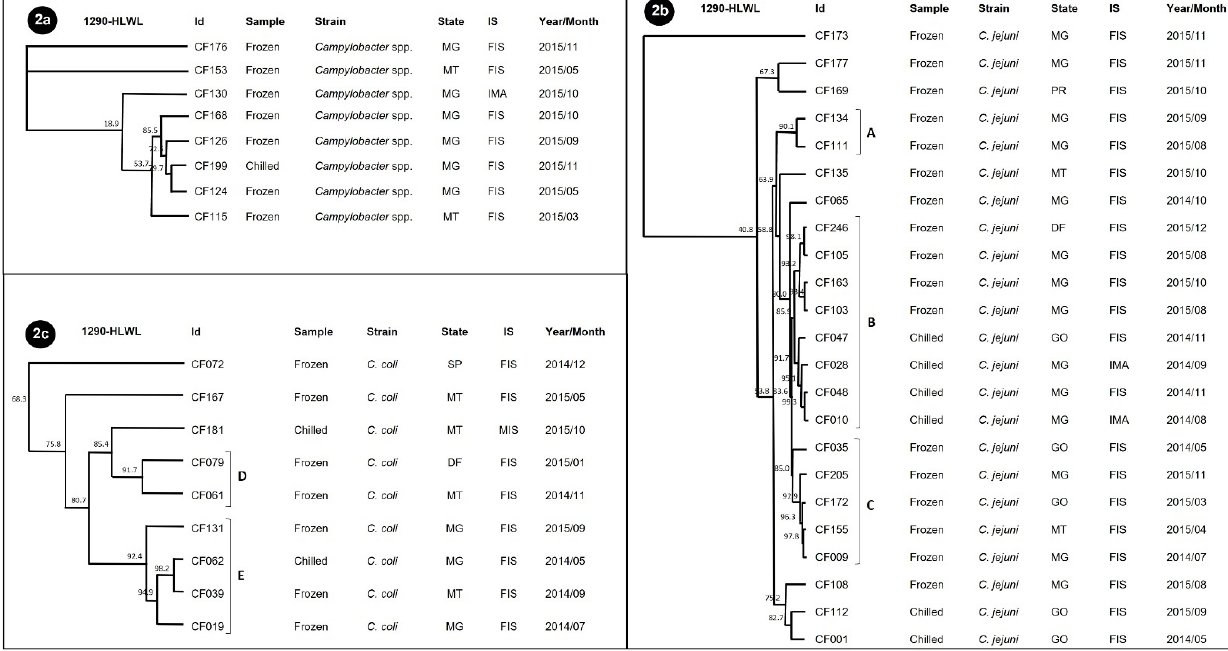
Figure 2. Dendrogram of the 40 Campylobacter spp. isolates from chilled and frozen chicken carcasses, from data generated by the RAPD-PCR technique with primers 1290 and HLWL, using the average from experiments and the UPGMA method with 85% optimization by the GelCompar program. ( 2a ) Results found for Campylobacter spp. ( 2b ) Results found for C. jejuni : ( A ) cluster with 90.1% homology; ( B ) cluster with 85.9% homology; ( C ) cluster with 85% homology. ( 2c ) Results found for C. coli : ( D ) cluster with 91.7% homology; ( E ) cluster with 92.4% homology. SP (São Paulo), MT (Mato Grosso), MG (Minas Gerais).